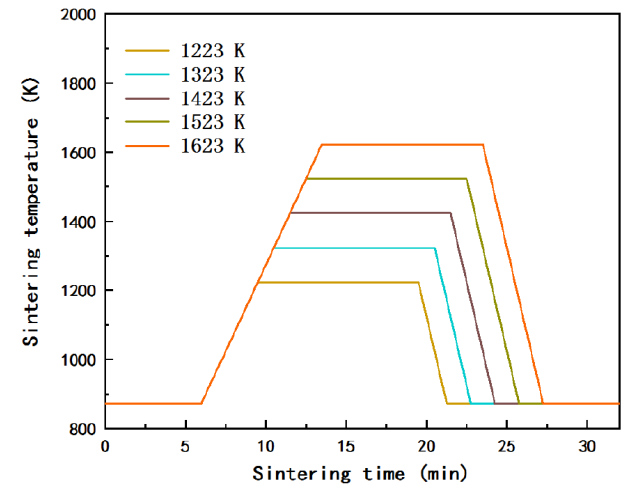
Figure 1. Sintering profiles of Ti-25Nb-6Zr alloy .